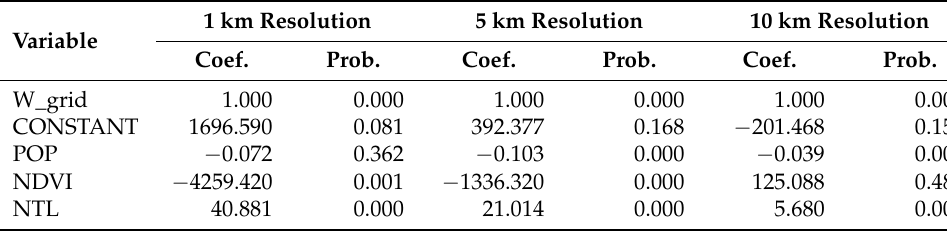
Table 4. Estimated results for the SLM.